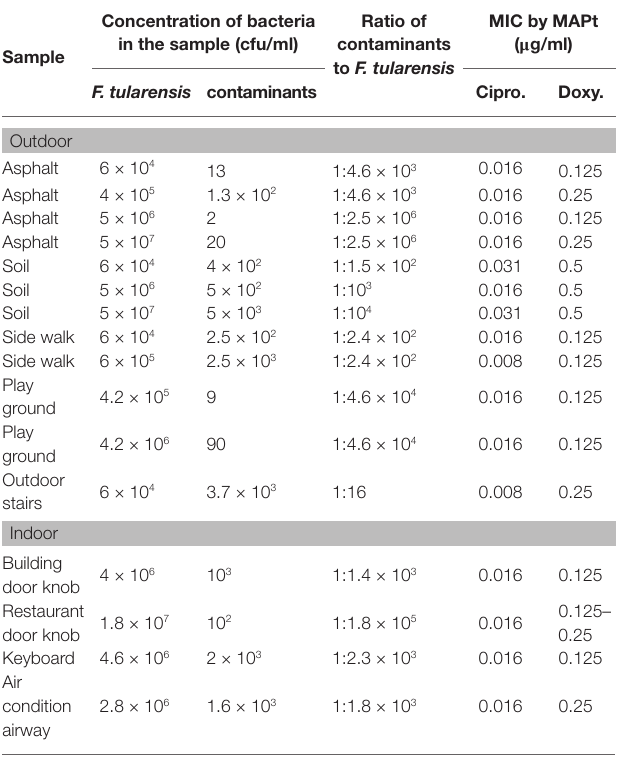
TABLE 3 | MIC values obtained by MAPt for F. tularensis spiked environmental samples. Concentration of bacteria in the sample (cfu/ml) Sample